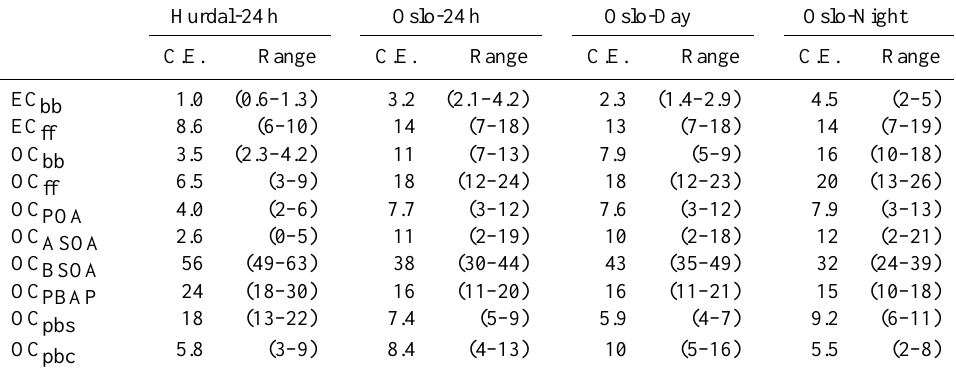
Table 6. Calculated percentage contributions to total carbon from LHS analysis, PM 10 , summer sampling (19 June–15 July 2006). C.E. is central estimate (50th percentile), range is 10th–90th percentiles of LHS results.